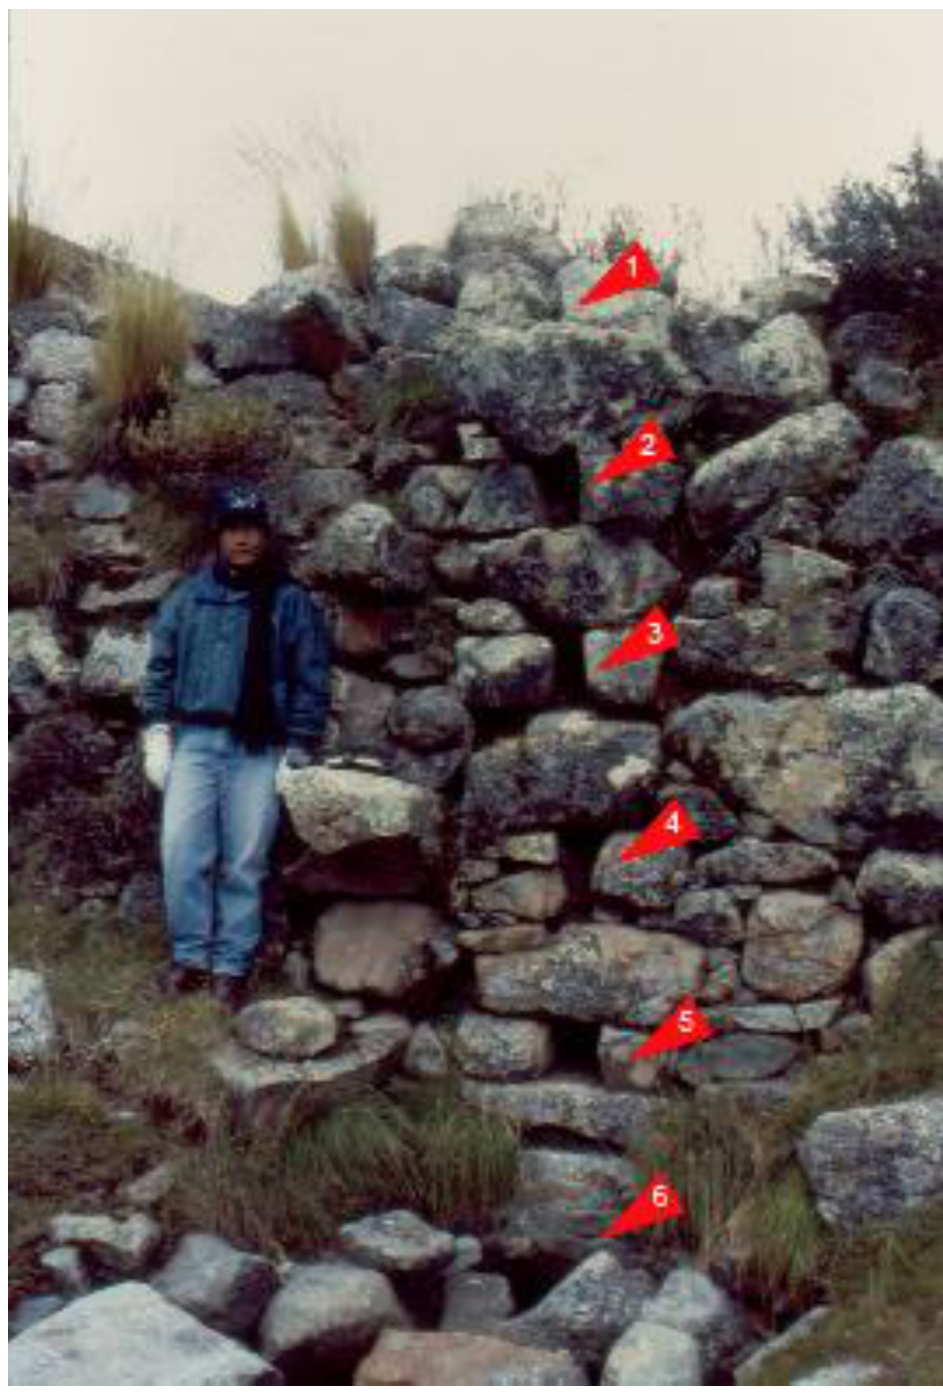
Figure 7. External face of Ricococha Baja [Ra 1] showing six sluices.